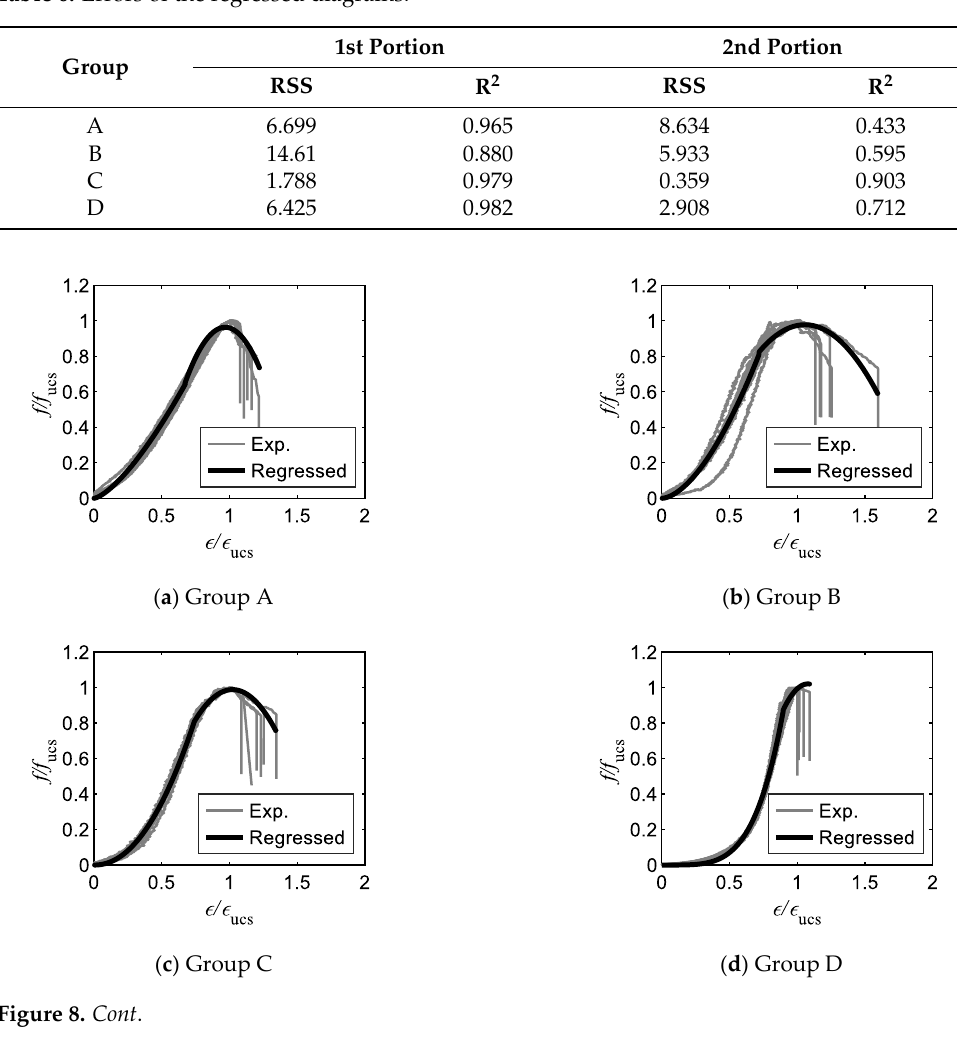
Table 6. Errors of the regressed diagrams.